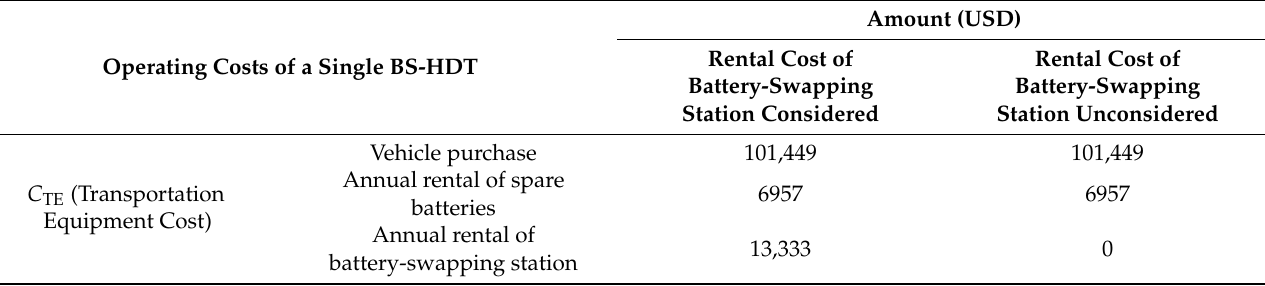
Table 2. Calculation of a single BS-HDT operating costs in a full operation cycle (5.5 years).